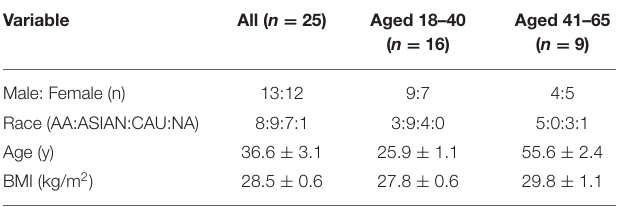
TABLE 2 | Subject demographic information at the screening